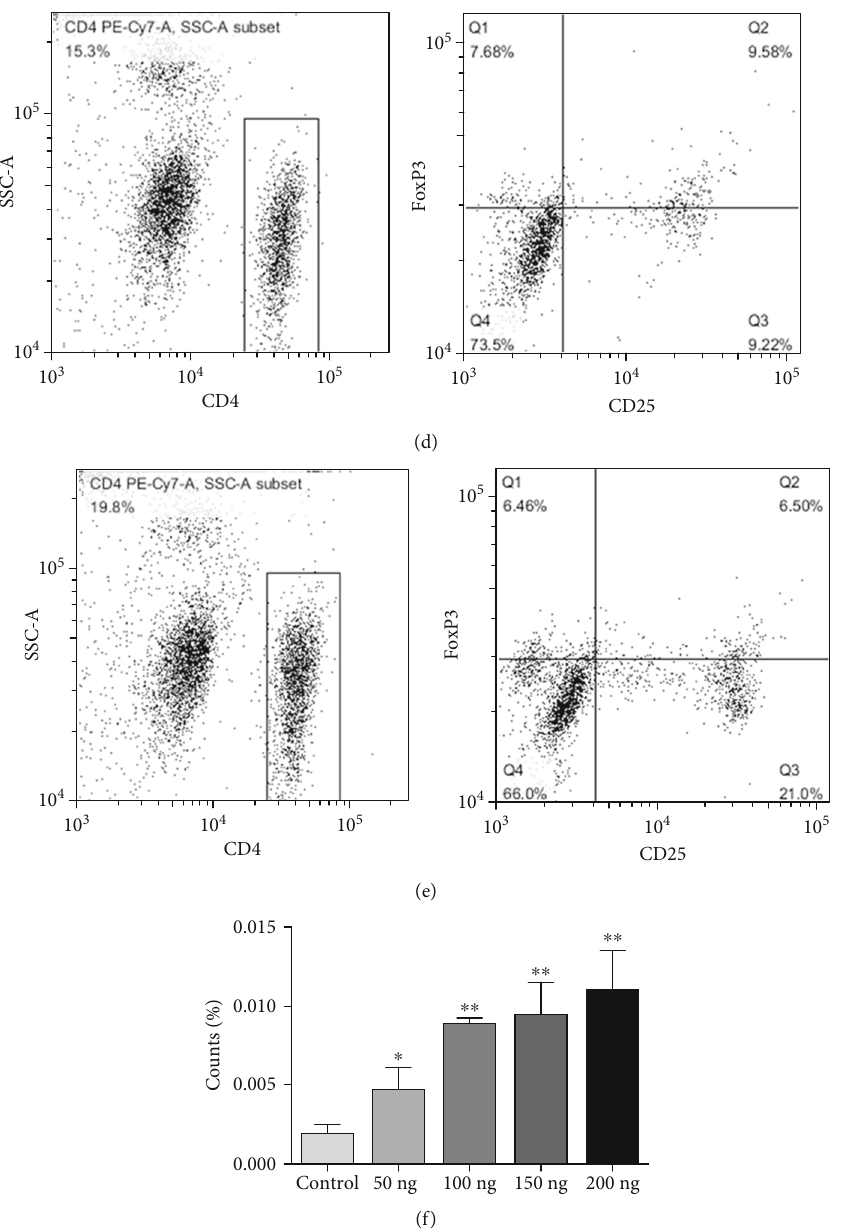
Figure 4: The proportion of CD4 + CD25 + FoxP3 + Tregs in VD3 groups from o ff spring. Compared with control group (a), the proportion of CD4 + CD25 + FoxP3 + Tregs was elevated in VD3 groups ((b) 50ng, (c) 100 ng, (d) 150 ng, and (e) 200 ng groups) from o ff spring in a dose dependency (f). Values are mean ± SEM ( n = 5 ), ∗ P < 0 : 05 vs. control and ∗∗ P < 0 : 01 vs.